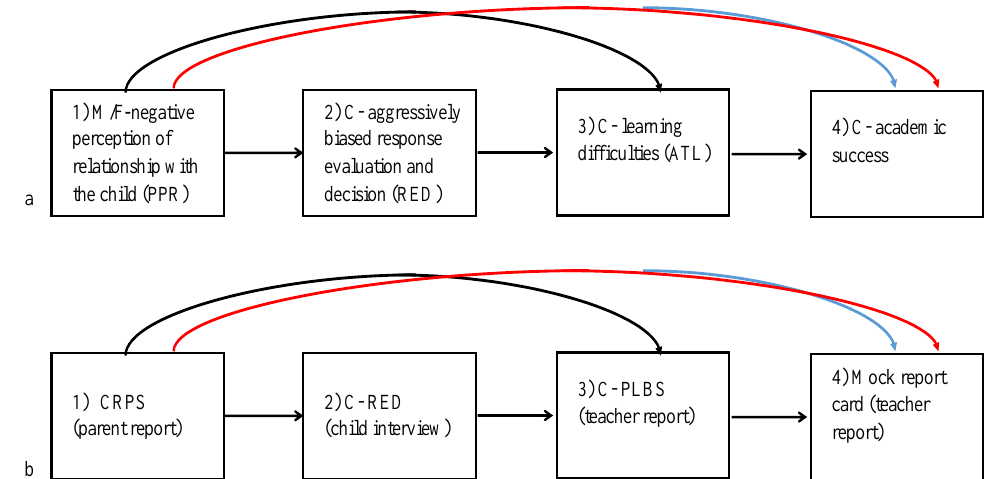
Figure 1. The study’s conceptual ( a ) and operational ( b ) models and expected effects. HO1: mother/father negative perception of relationship with the child (NPR) associates with child’s learning difficulties in preschool through child’s aggressive evaluation (RED) (black path); HO2: mother/father NPR associates with child’s academic performance in preschool through child’s aggressive evaluation (red path); HO3: Child RED and ATL mediate associations between parents’ NPR and child’s academic performance in preschool. CRPS = the short-form child–parent relationship scale; C-PLBS = Preschool Learning Behavior Scale.